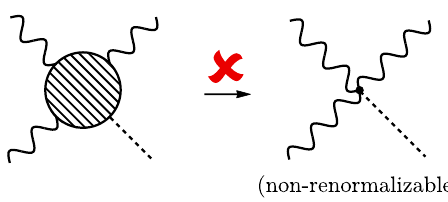
Figure 3 . Our procedure to obtain genuine 3-loop neutrino mass diagrams and topologies may not be valid in the presence of vector (cid:12)elds. In this example, a 1-loop fragment of a larger diagram cannot be contracted into a renormalizable point interaction, see text.